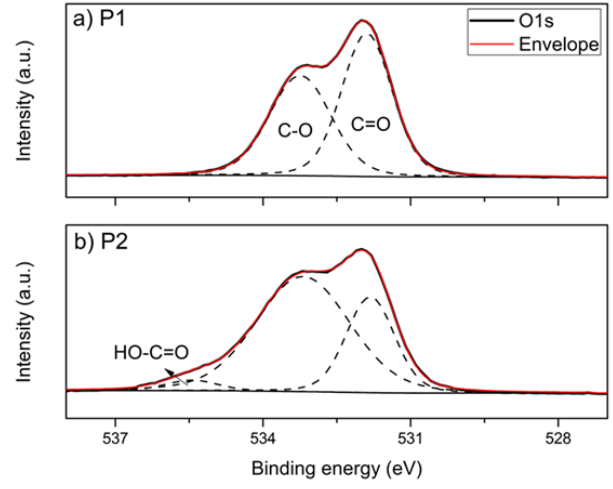
Figure 3. Resolved XPS spectra of O(1s) for ( a ) P1 and ( b ) P2. Table 1. XPS parameters for plasticizers.